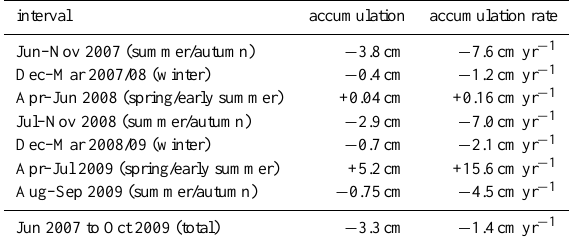
Table 1. Accumulation and ablation (negative sign) determined by ultrasonic ice-height measurements in the Eispalast over two years (values determined from data by F. Obleitner, personal communica- tion, 2010; see also Obleitner and Sp¨otl,